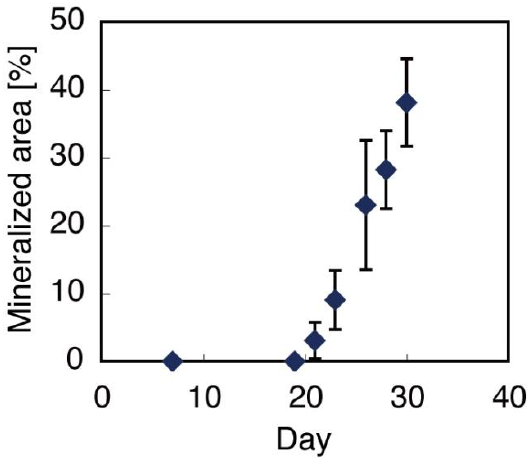
Figure 7. Calcification (nodule formation) in 2D bone marrow derived mesenchymal stem cells (BMSCs) culture was detected at day 19; the area increased in accordance with the culture